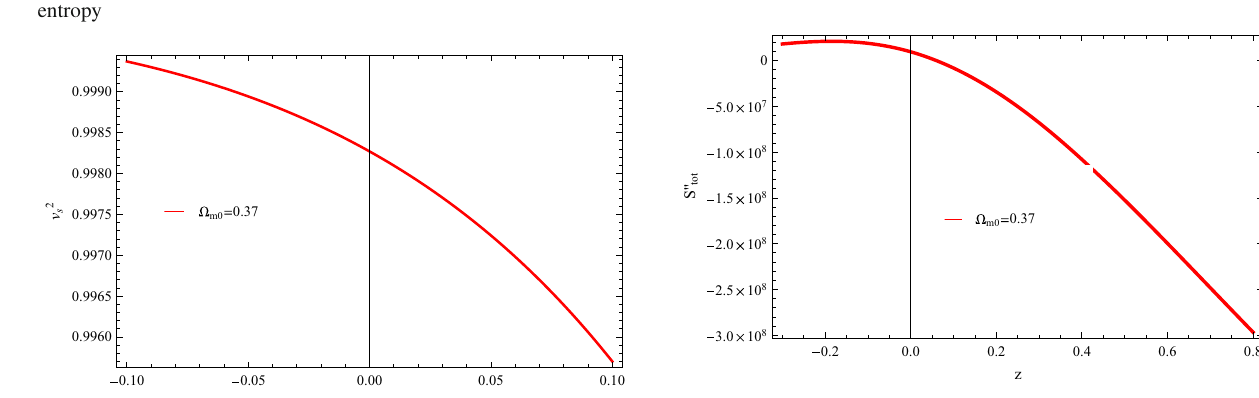
Fig. 16 Plotof S (cid:5)(cid:5) tot versus z